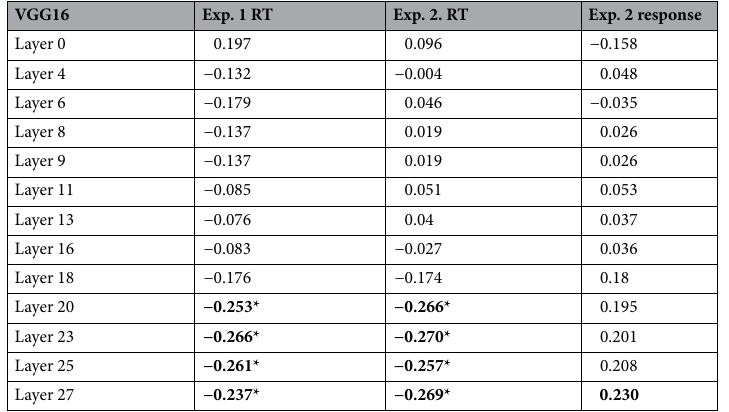
Table 1. Pearson correlation between human behavioral performance and similarity in the VGG16 CNN network layers. Pearson r values between behavior (Experiment 1 reaction time, Experiment 2 reaction time, and Experiment 2 relatedness response) are listed in each cell. Cells marked with bold indicates correlations that were significant at p < .05, * indicates p values that withstood a false discovery rate correction of multiple comparisons across the layers. Significance of the correlation was only found in the later layers of